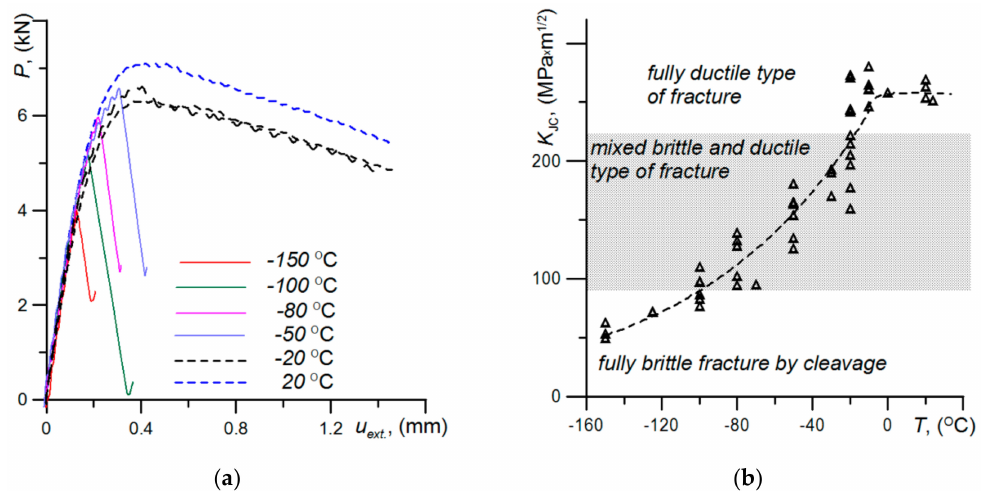
Figure 8. Fracture mechanisms of S960QC steel: ( a ) The diagrams of single edge notch during bending (SENB) specimens loading at di ff erent temperature; ( b ) three zones of di ff erent cracking types on brittle-to-ductile dependence.